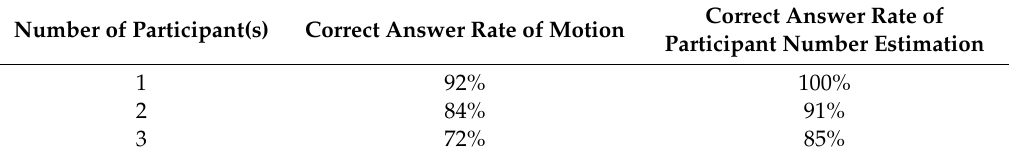
Table 7. Result of multi-target detection with the 3D